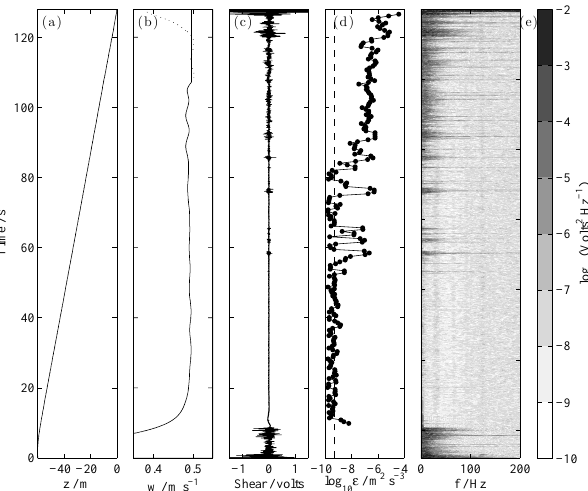
Fig. 3. Spectrogram of a profile taken at 17:15LMT (e) . The depth and corresponding rise velocity are shown in (a) and (b) . A uniform rise speed is adopted in the upper 10m (solid line) to filter out wave effects in the pressure signal (dotted line). (c) shows the raw shear signal in volts and the calculated dissipation rate is in (d)